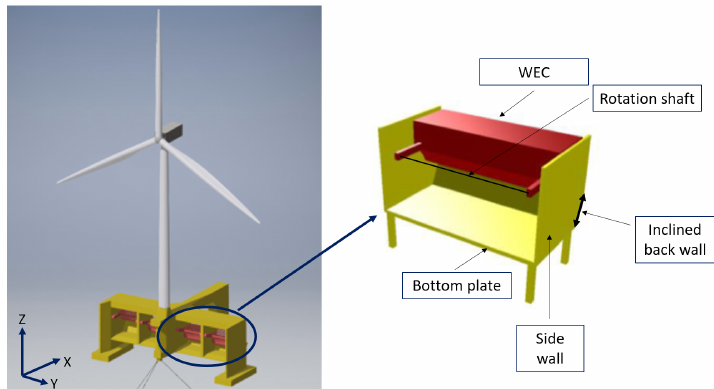
Figure 1. Left : Floating Power Plant (FPP) conceptual design, which consists of a wind turbine, 4 wave energy converters (WECs) (in red), a semisubmersible platform (in yellow) and a mooring system. Right : Model scaled single, pitching WEC (in red), with a fixed substructure representative of the semisubmersible (“bottom box”, in yellow). The rotation shaft is always above the still water line.